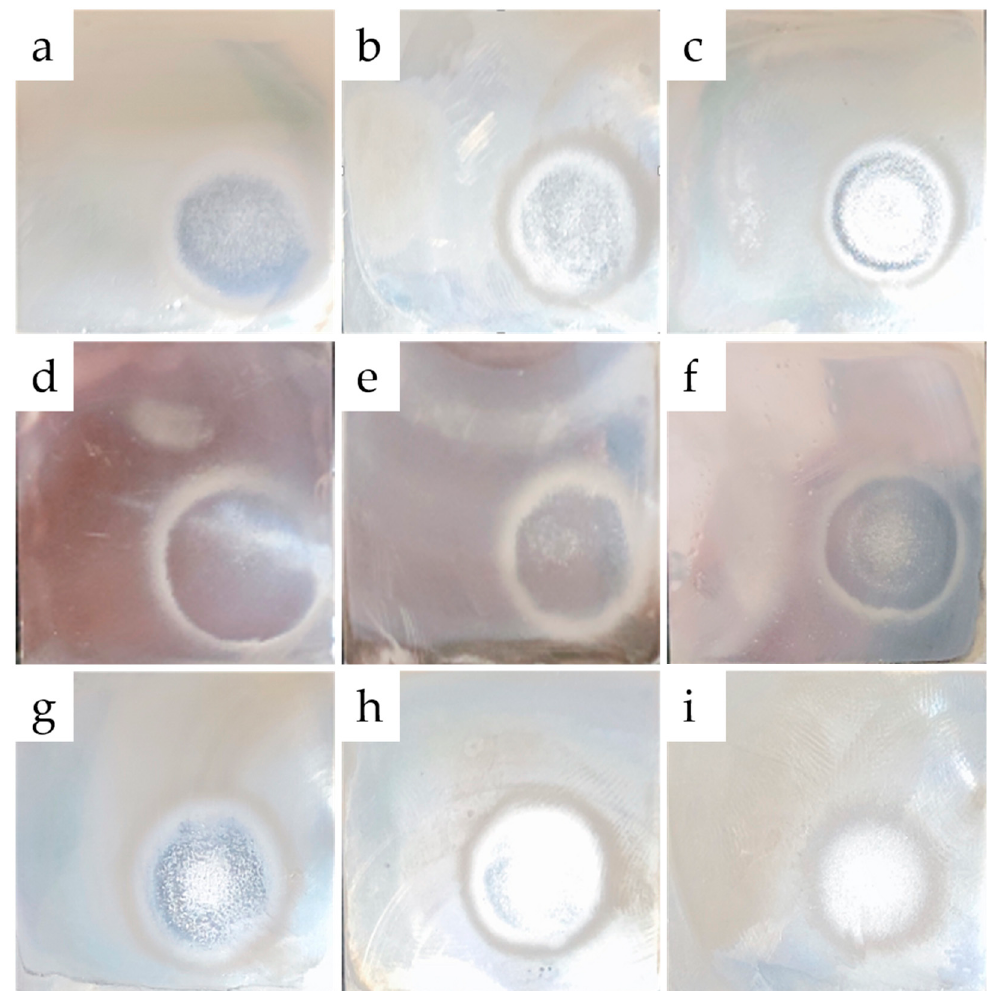
Figure 5. The workpiece surfaces at different ultrasonic amplitudes. ( a ) Ultrasonic amplitude of 30%; ( b ) Ultrasonic amplitude of 35%; ( c ) Ultrasonic amplitude of 40%; ( d ) Ultrasonic amplitude of 45%; ( e ) Ultrasonic amplitude of 50%; ( f ) Ultrasonic amplitude of 55%; ( g ) Ultrasonic amplitude of 60%; ( h ) Ultrasonic amplitude of 65%; ( i ) Ultrasonic amplitude of 70%.